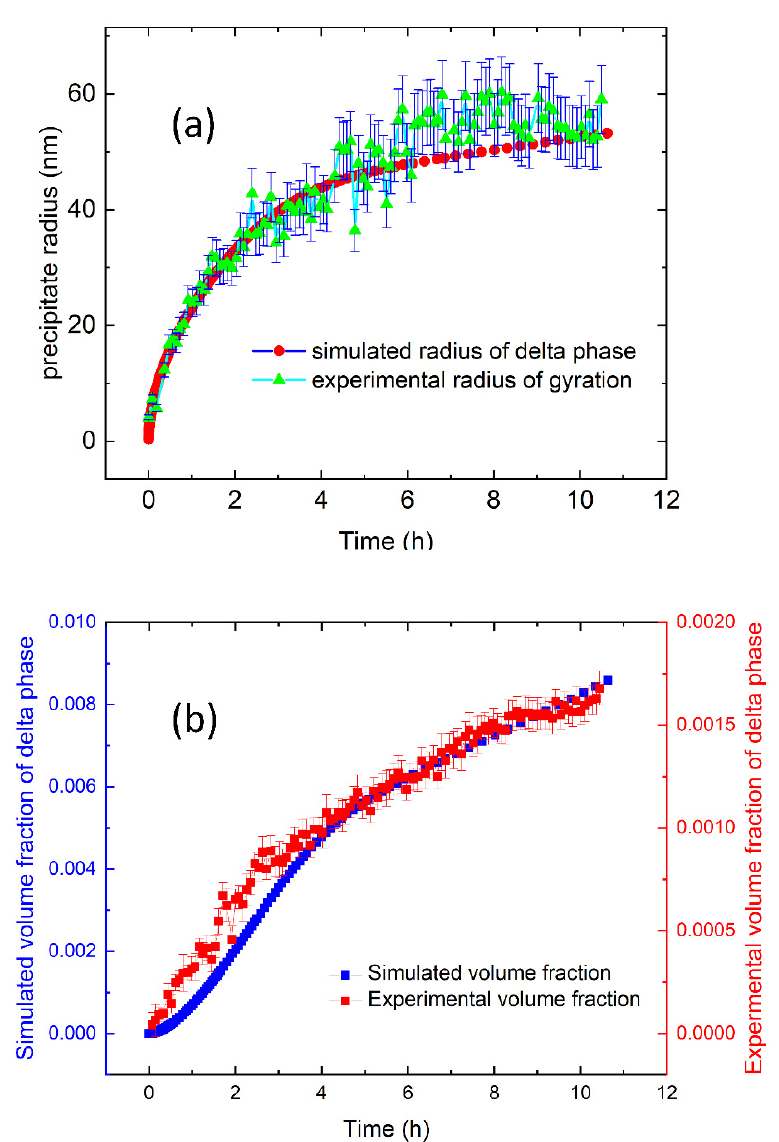
Figure 8. ( a ) A comparison between the calculated (simulated) radius and experimental mean radius of gyration of the δ phase precipitates at 700 ◦ C as a function of annealing time. Here, we assumed a spherical morphology for the precipitates for the simulation. Accordingly, we calculated the radius of gyration of the platelet δ phase precipitates based on experimental values reported in Figure 7b. ( b ) A comparison between the calculated and experimental volume fraction of the δ phase precipitates at 700 ◦ C as a function of